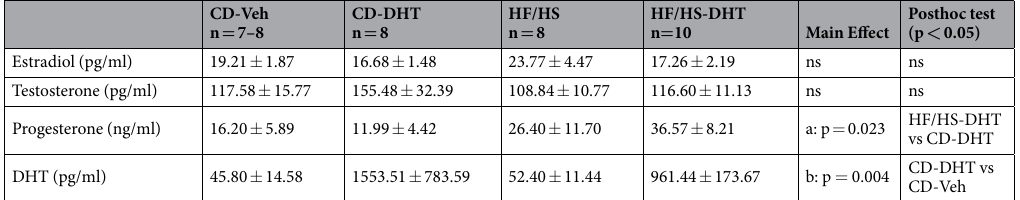
Table 3. Sex steroids in the serum of dams on GD 18.5. CD, control; HF/HS, high fat/high sucrose diet; DHT, dihydrotestosterone. Data are Mean values ± SEM. a = Main effect of diet [F (1,30) 5.77, p = 0.023]. b = Main effect of injection [F (1.30) 9.97, p = 0.004] There was no interaction between diet and DHT injection for any of the